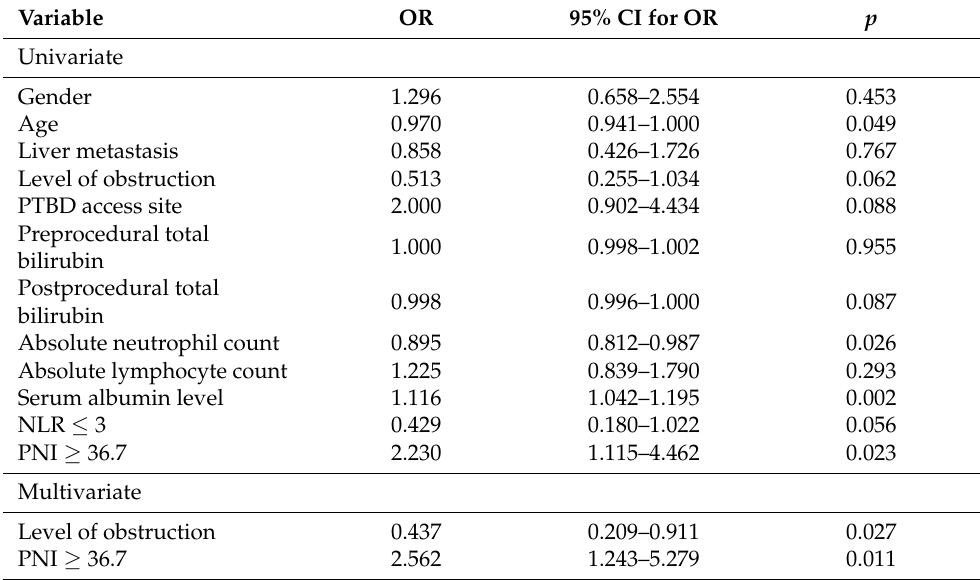
Table 2. Univariate and multivariate logistic regression analysis with 60 days survival as dependent variable.